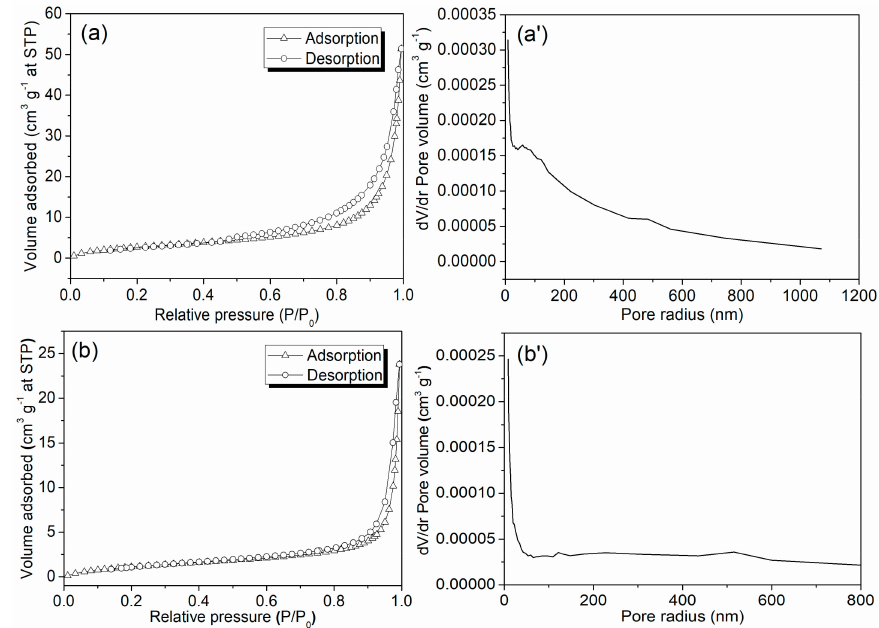
Figure 4. N 2 adsorption-desorption isotherms and pore size distributions of Zn / Al LDH ( a , a’ ) and Mn1@aL ( b , b’